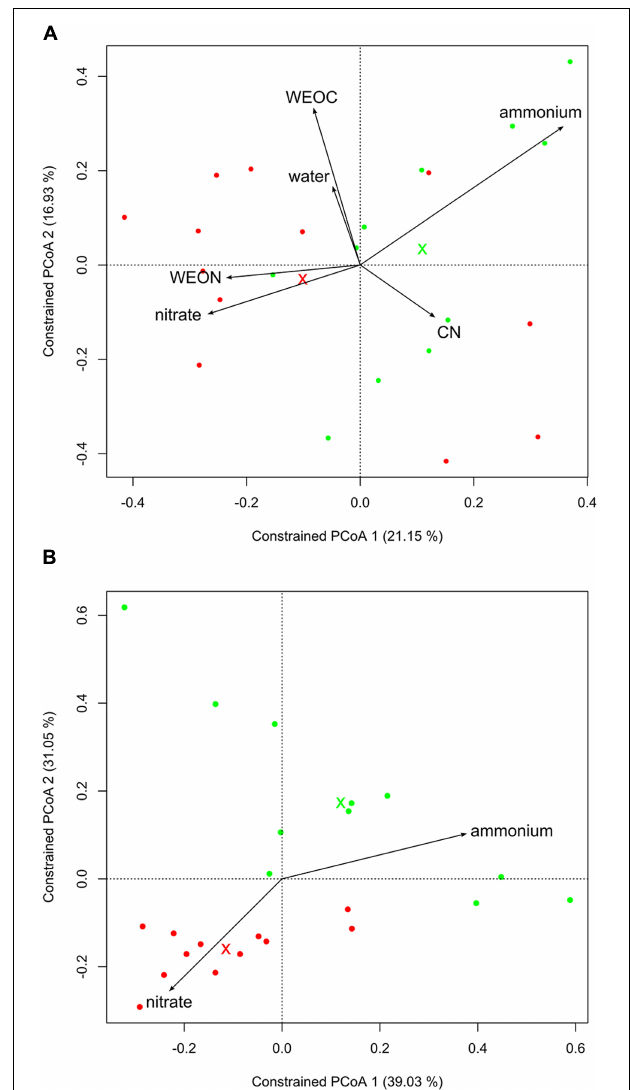
FIGURE 2 | Ternary plots of community structure in roots, rhizosphere and bulk soil. The colors represent the classes to which corresponding OTUs were assigned. (A) Represents distribution under high LUI, (B) under low LUI. The size of the plotted dots corresponds to the abundance of the OTUs with respect to each compartment. The position of each circle is determined by the contribution of the indicated compartments to the total abundance.